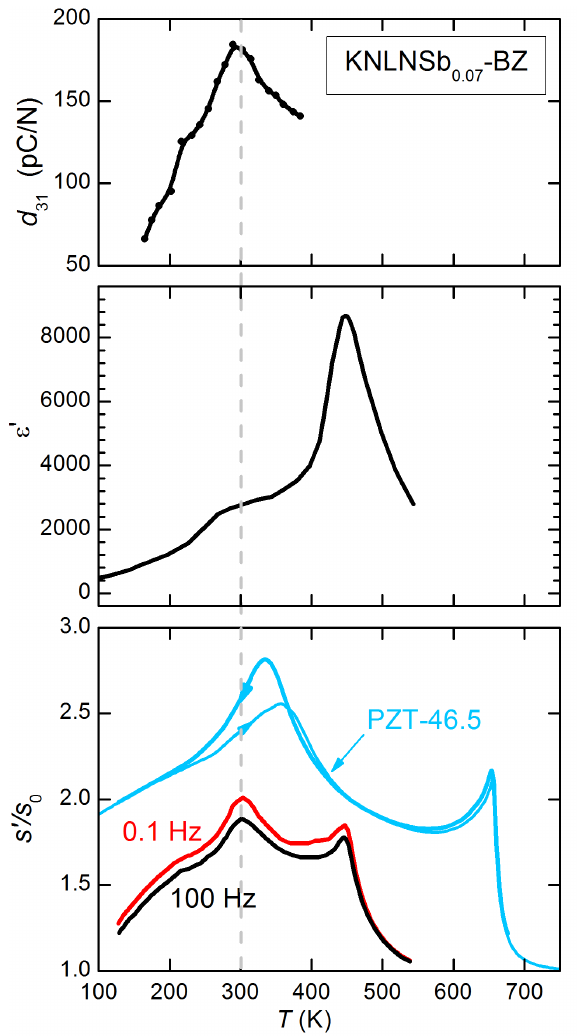
Figure 21. Elastic compliance s (cid:48) , dielectric susceptibility ε (cid:48) and piezoelectric coefficient d 31 of KNLNSb 0.07 − BTZ (data extracted from [195]). The compliance is normalized to its value in the PE phase and compared with that of PZT-46.5 from Figures 12 and